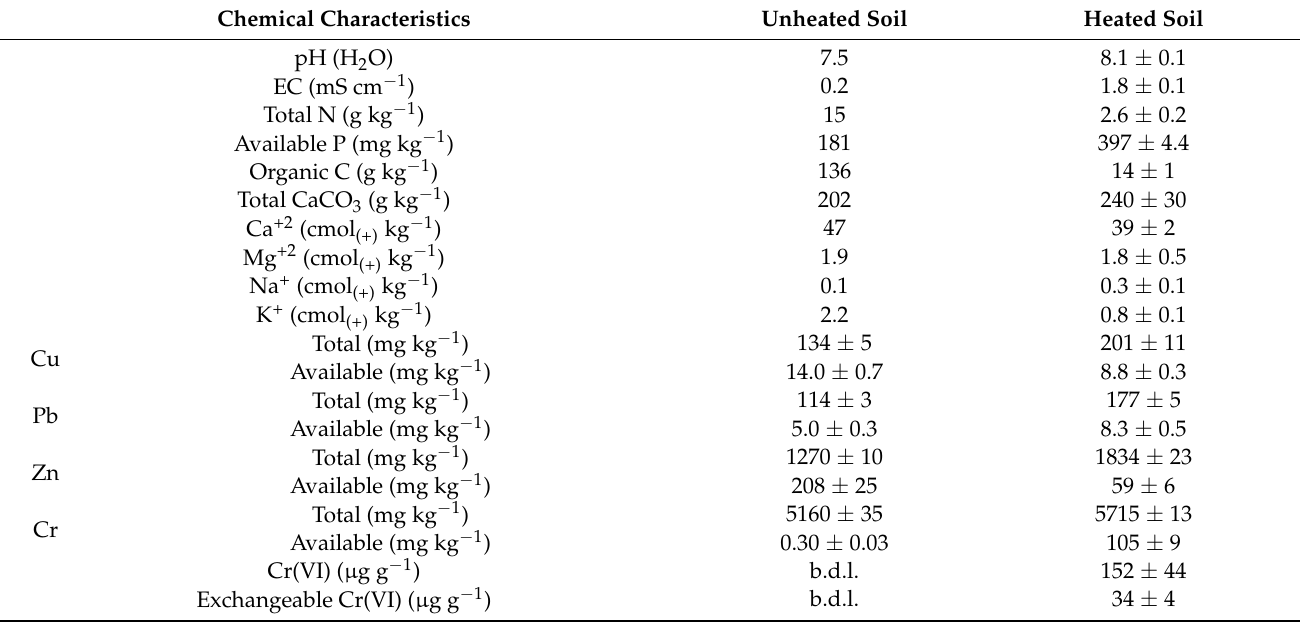
Table 1. Chemical properties and potentially toxic element (PTE) concentrations in the unheated and heated soils (mean value ± standard deviation, n = 3). Only one determination was performed for the basic chemical properties of the unheated soil, being a composite